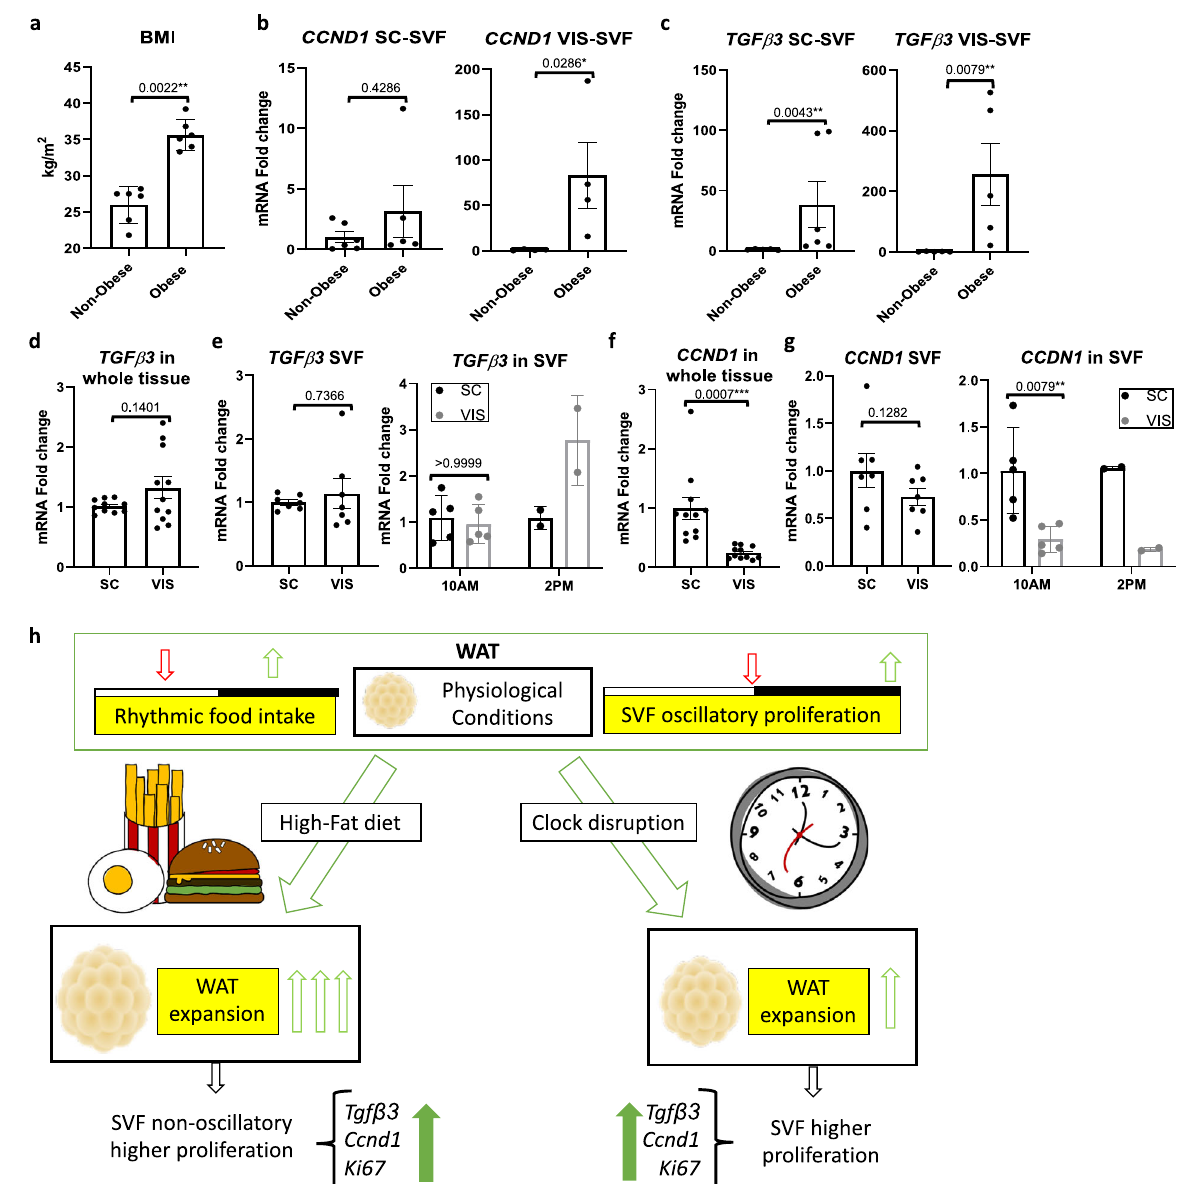
Fig. 8 TGF β 3 and CCND1 expression varies across human adipose tissue depots. a Body mass index (BMI) from non-obese and obese human patients undergoing prostatectomy intervention ( n = 6 patients/group). b , c RT-PCR analysis reveals expression of CCND1 ( b ) and TGF Β 3 ( c ) in periprostatic visceral (VIS) or abdominal subcutaneous (SC) SVF prepared from prostatectomy intervention subjects ( n = 6 patients/group). mRNA levels from SC fat in lean individuals set to 1. d RT-PCR analysis reveals expression of TGF Β 3 in omental (VIS) and subcutaneous (SC) tissue from obese patients undergoing bariatric surgery ( n = 12 patients/fat pad). mRNA levels from the SC fat set to 1. e RT-PCR analysis reveals expression of TGF Β 3 in VIS- and SC-derived SVF ( n = 8 patients/fat pad) (left panel) and isolated SVF in the morning (approximately 10:00) ( n = 6 patients/fat pad) vs. afternoon (approximately 14:00) ( n = 2 patients/fat pad) (right panel) from patients undergoing bariatric surgery. mRNA levels from the SC (left panel) or the SC at 10:00 (right panel) were set to 1. f RT-PCR analysis reveals expression of CCND1 in VIS and SC fat tissue from patients undergoing bariatric surgery ( n = 12 patients/fat pad). mRNA levels from the SC fat were set to 1. g RT-PCR analysis reveals expression of CCND1 in VIS and SC isolated SVF ( n = 8 patients/fat pad) (left panel) taken at 10:00 ( n = 6 patients/fat pad) or 14:00 ( n = 2 patients/fat pad) (right panel) from obese patients subjected to bariatric surgery. mRNA levels of all SC (left panel) or the SC at 10:00 (right panel) were set to 1. h Working model of diurnal progenitor proliferation. Data are represented as mean ± SEM. * p < 0.05, ** p < 0.01, *** p < 0.001, **** p < 0.0001. Signi fi cance ( p < 0.05) determined by two-tailed Mann – Whitney U test in ( a – c , e , g ); two-tailed unpaired t -test in ( d , f